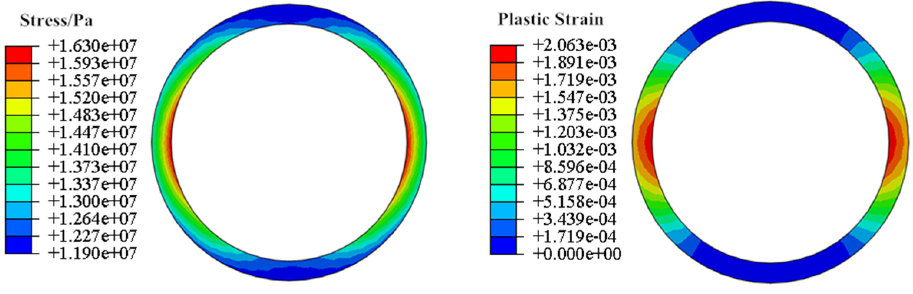
Figure 10. Effect of different porosity on bearing characteristics.